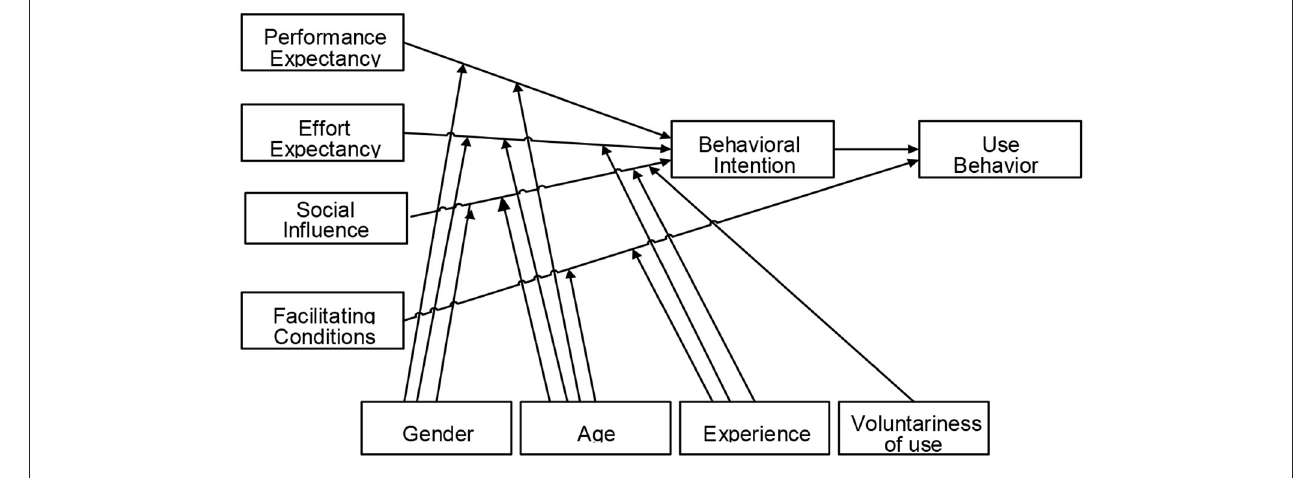
FIGURE 1 | The UTAUT model.